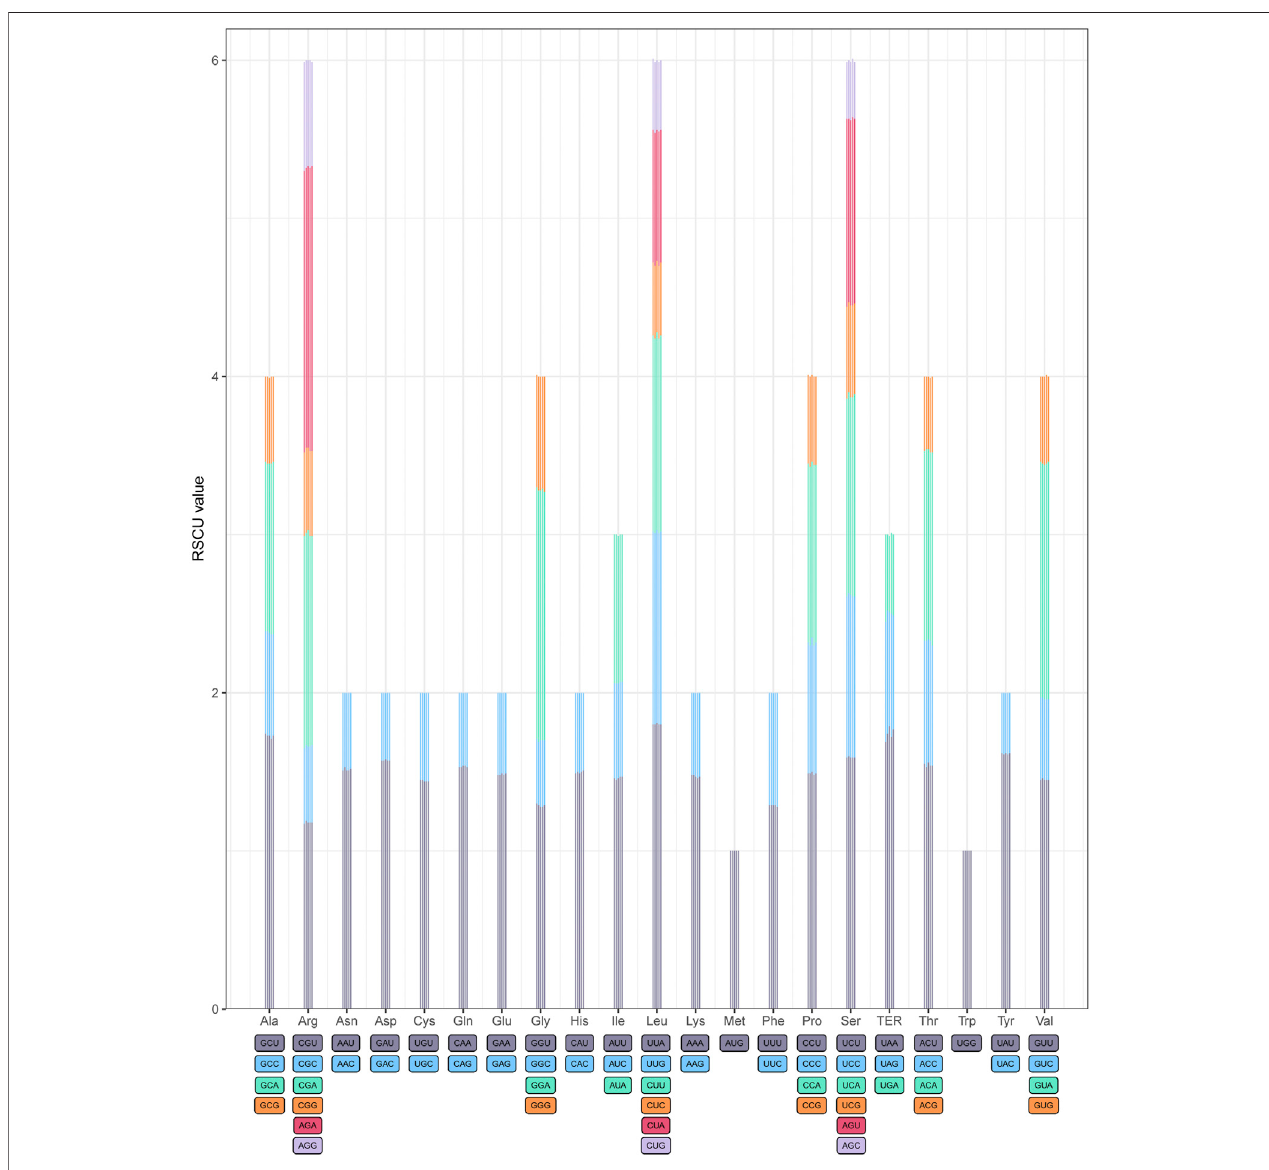
FIGURE2 | Codon content oftwentyamino acidsin all protein-codinggenes of fi ve Acer species cp genomes. The histogram ofeach amino acid indicated codon usage within Acer (from left to right: A. mandshuricum , A. pictum , A. tataricum , A. tegmentosum , and A. ukurunduense ).